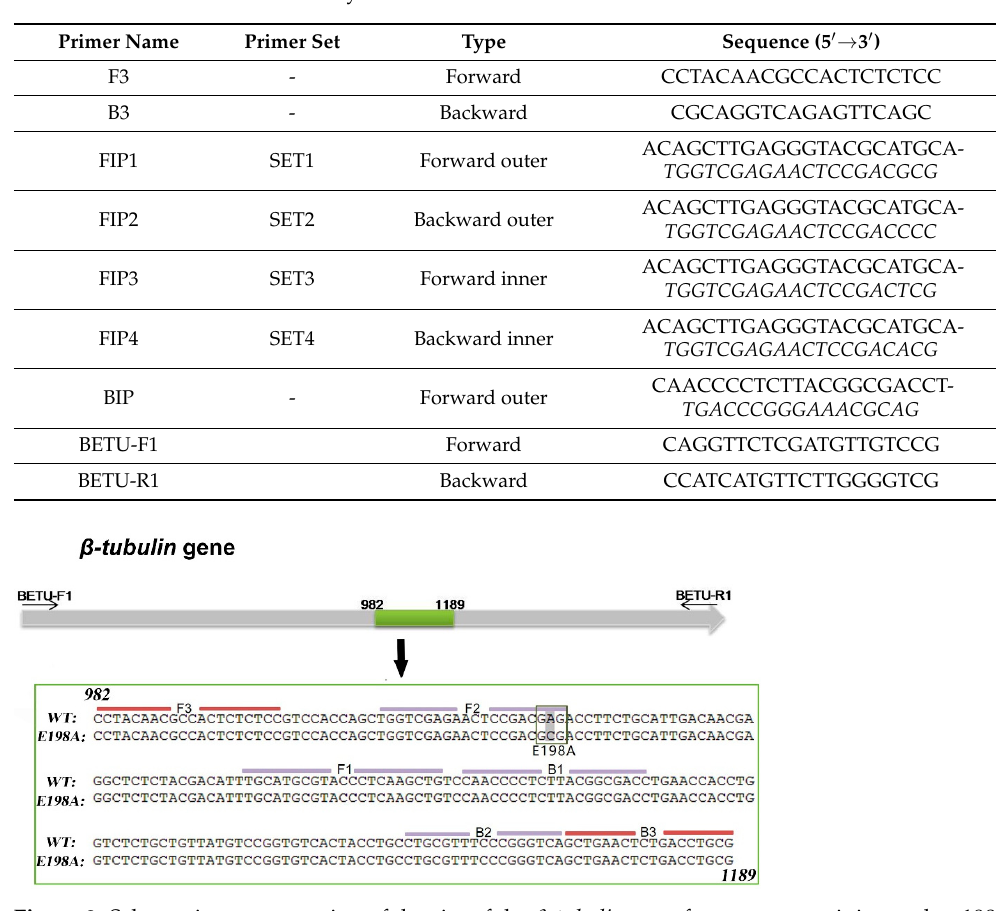
Table 1. Primers used in this study.